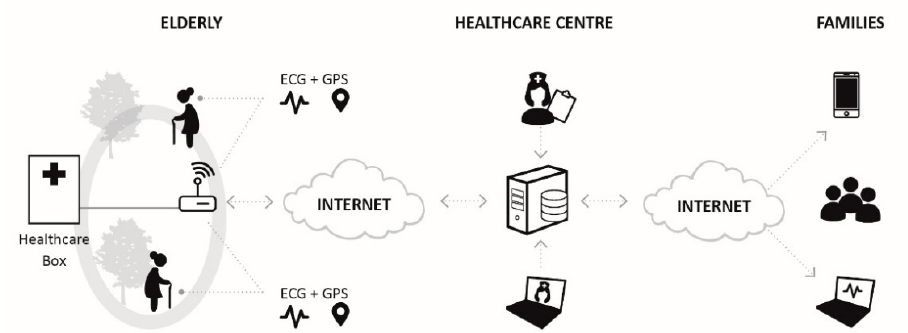
Figure 6. An outdoor intelligent architecture of the proposed healthcare system. (Adapted from Wang et al. [36]).